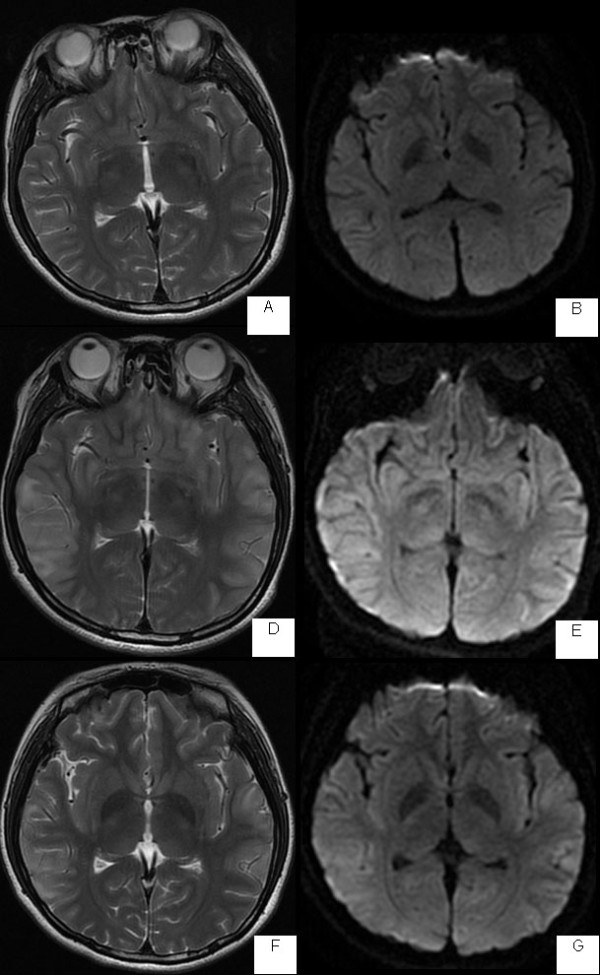
MRI of a 19 year-old SLE patient who presented with stupor. T2-weighted image (A) and Diffusion-weighted image (B) show normal. After 2 weeks repeat MRI, T2-weighted image (C) shows high signal lesions in bilaterally temporooccipital white matter. DWI (D) shows lesion isointensity. Follow-up T2-weighted image (C) obtained 2 week after (E) reveals almost resolution of high signal area in bilaterally lesion region. DWI (F) reveals lesion isointensity.